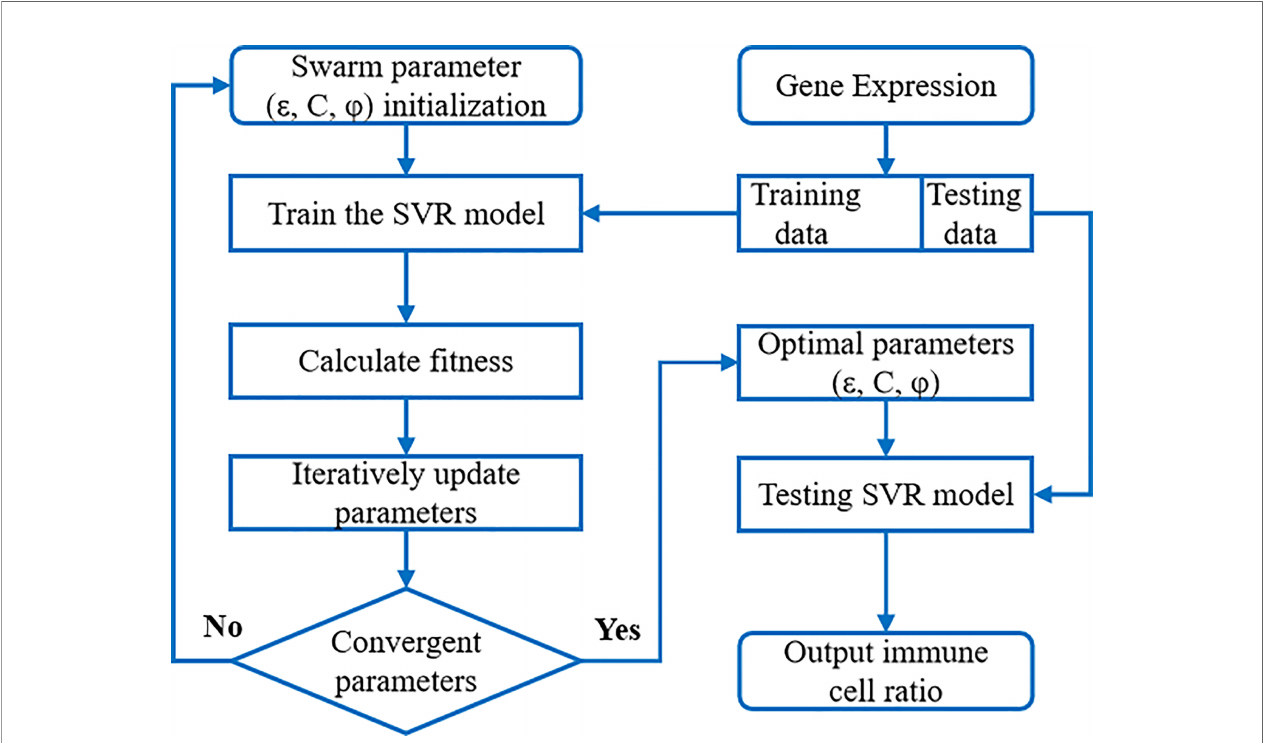
FIGURE 2 | The fl ow chart of PSO-SVR algorithm. SVR model was embedded into the PSO algorithm to calculate the optimal parameters; then SVR model with optimized parameters was applied to the immune cell